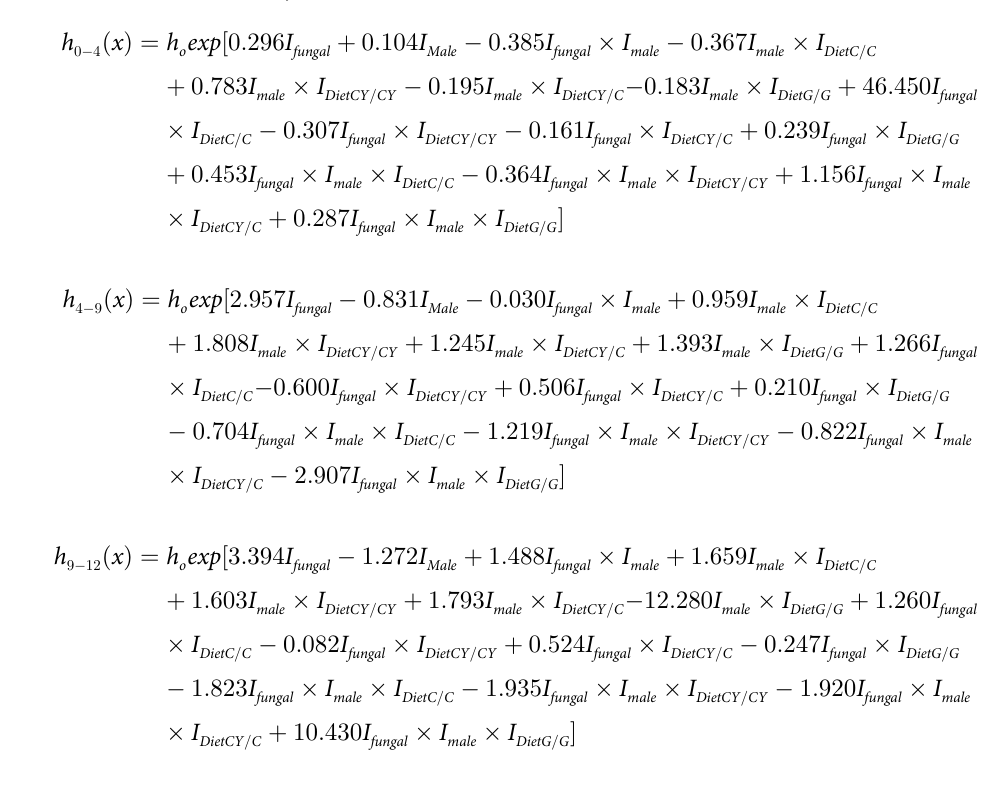
Experiment 5: Effects of varying levels of yeast supplementation on sexual dimorphism in post-infection survival of D . melanogaster inoculated with B . bassiana strain GHA.